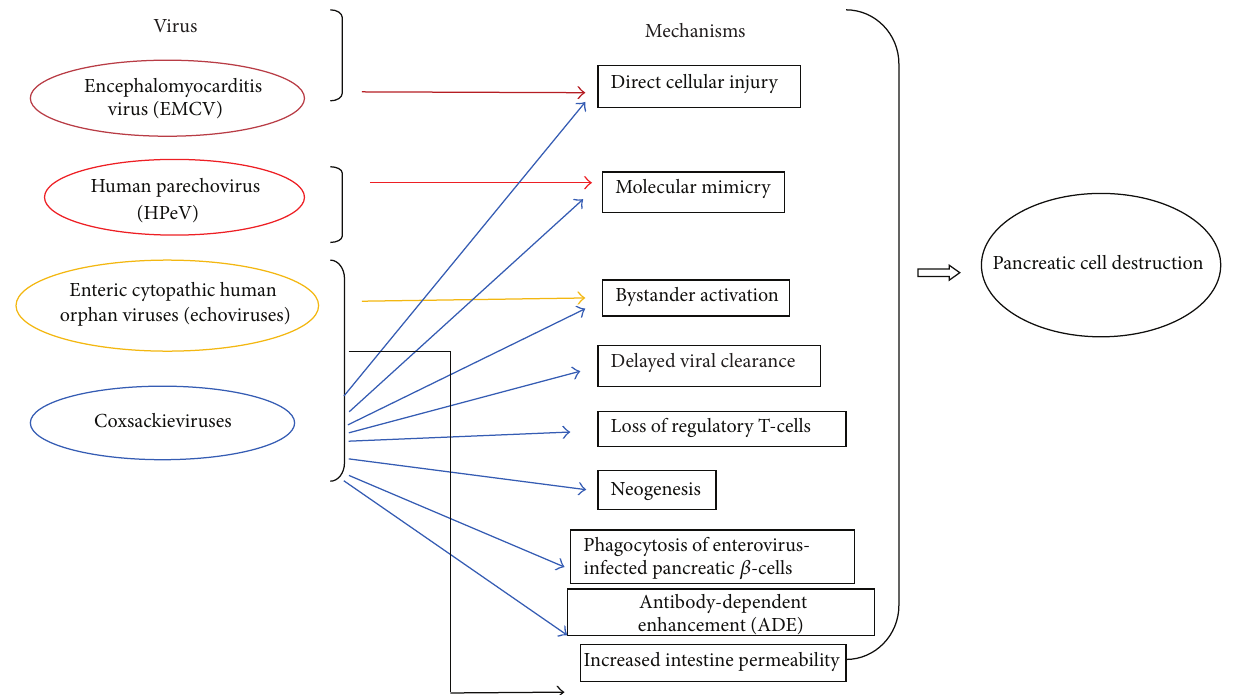
Figure 2: Putative mechanisms suggested for the induction by members of the family Picornaviridae . (Viruses linked to the induction of T1D in experimental animals (natural nonhuman hosts) or through clinical studies, having a potential to infect humans in rare conditions.) Factors influencing the mechanisms involved in the beta cell destruction by these viruses. (a) Genes related to infection putatively influencing the mechanisms: HLA-DR, melanoma differentiation-associated protein-5, and interferon induced helicase 1. (b) Innate immunity: interferons, tumor necrosis factor, and interleukins. (c) T- and B-lymphocytes, viral antibodies, islet cell antibodies, glutamic acid decarboxylase antibodies, antibody against insulin, and tyrosine phosphatase-related IA2-A